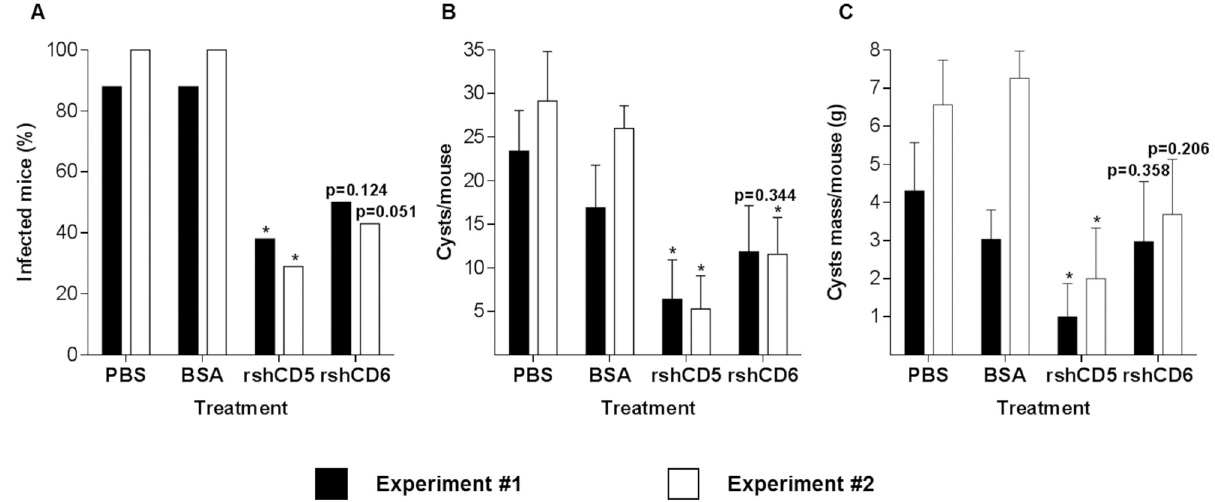
Fig 6. Infusion rshCD5 or rshCD6 protects mice from secondary CE. The anti-parasite prophylactic potential of rshCD5 or rshCD6 was assessed in the murine model of secondary CE by infusing PBS, rshCD5, rshCD6 or BSA (25 μ g/dose/mouse, i.p.) 1 h before and 1 h after i.p. inoculation of 2,000 highly viable PSC/mouse into Balb/c mice (n = 6–8 mice per experimental group). At 14 months post infection, mice were euthanized, and the peritoneal hydatid cysts within each mouse were counted and weighted. Results are displayed as percentage of infected mice ( A ), number (mean +/- SEM) of hydatid cysts per mouse ( B ), and total wet weight (mean +/- SEM) of hydatid cysts per mouse ( C ). The experiment was performed twice. ( � ) Significant differences ( P < 0.05) respect to the PBS group were assessed by either Fisher’s exact test ( A ) or Mann-Whitney U-test ( B and C ).